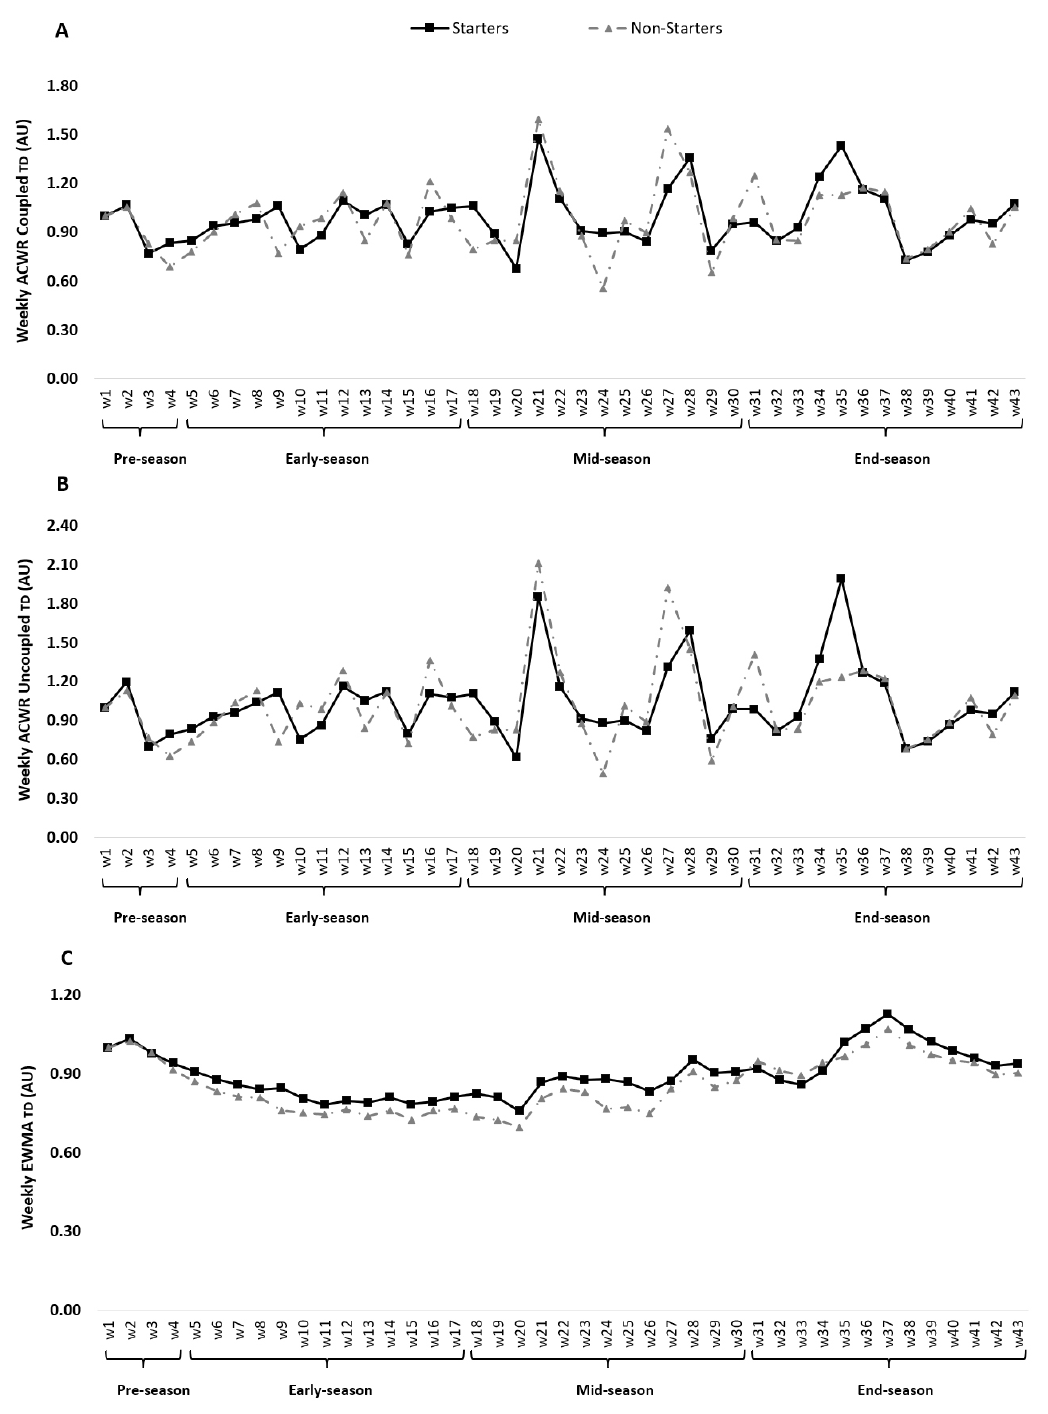
Fig. 1. ACWR coupled (A), ACWR uncoupled (B), and EWMA (C) variations calculated based on TD across 43 weeks for starters and